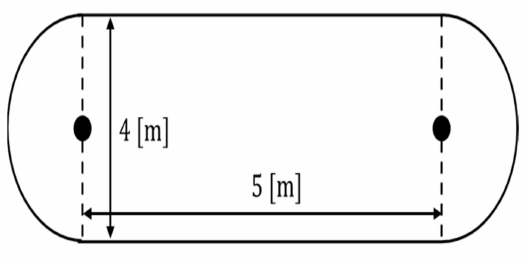
Figure 10. Ellipse path tracking scenario.